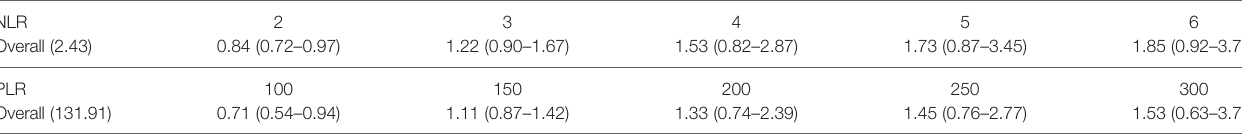
TABLE 2 | Weighted odds ratio and 95% con fi dence intervals of sarcopenia by levels of NLR or PLR.